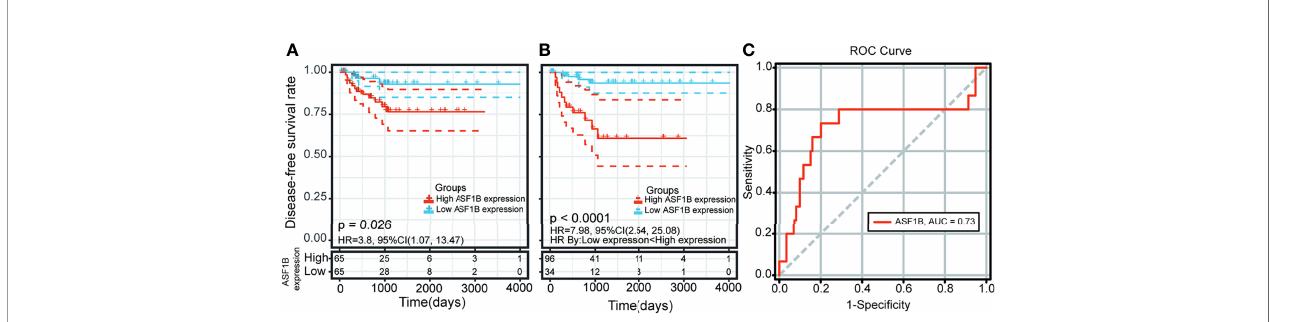
FIGURE 7 | Kaplan-Meier curve and receiver operating characteristic (ROC) curve analysis of disease-free survival (DFS) in male thyroid carcinoma patients based on ASF1B expression levels. (A) Patients were divided into low- and high-expression groups according to the median value of ASF1B expression. (B) Patients were divided into low- and high-expression groups according to the best cutoff points (2.96) determined by the ROC curve analysis. (C) Area under the ROC curve (AUC) of ASF1B expression in male thyroid carcinoma patient tumors.